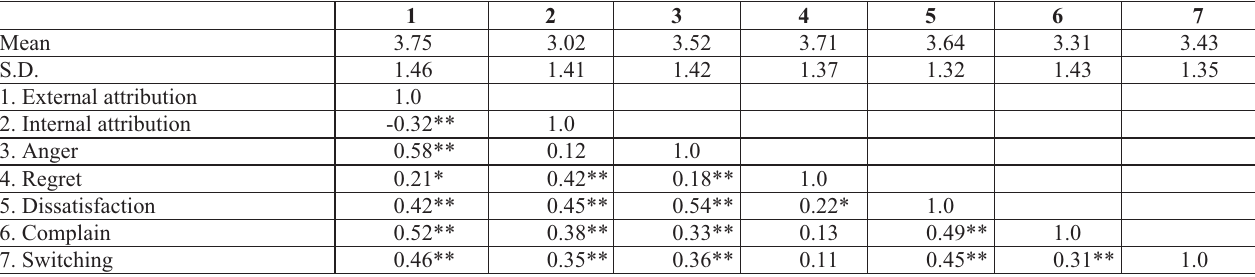
Table 2: Mean, standard deviation, and correlation matrices